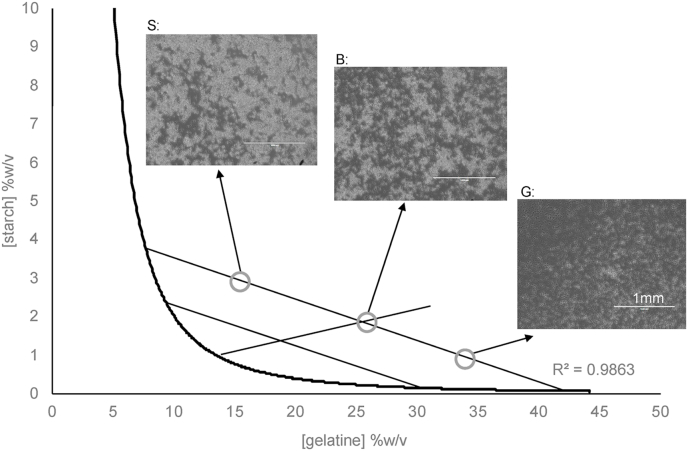
Phase diagram of a gelatine – acid thinned mixture (60 °C). Different microstructures observed include S: a starch dominating structure (light aggregates) with gelatine (dark clear phase) dispersions, B: a bicontinuous structure and G: a gelatine dominating structure with starch aggregate dispersions. Scale bars = 1 mm.